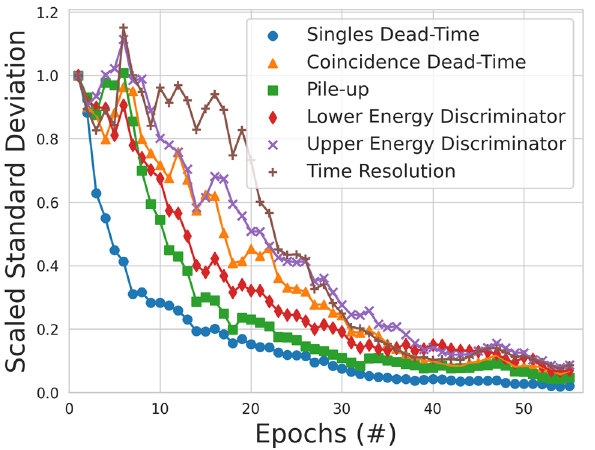
Figure 9. The standard deviation of the parameter value guesses tried by ACCES. A lower standard deviation represents lower uncertainty in discovering the optimal parameter values.